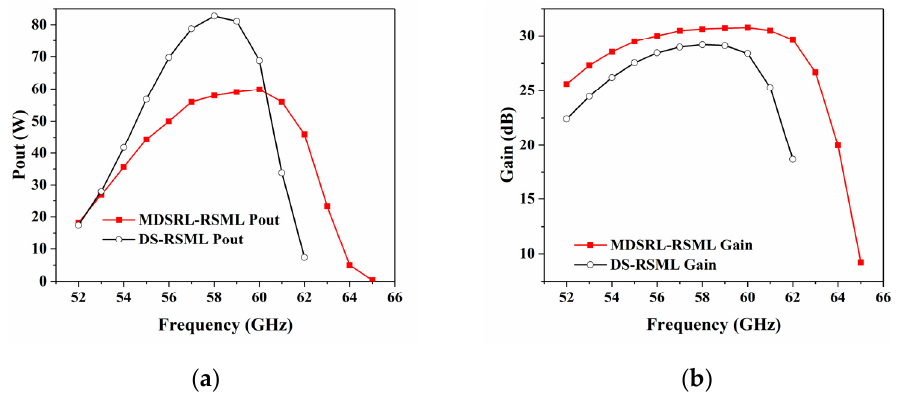
Figure 12. ( a ) Average output power and ( b ) gain versus frequency for the DS-RSML SWS and MDSRL-RSML SWS.